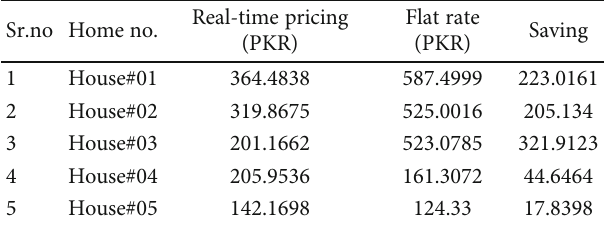
Table 10: Real-time pricing and fl at rate comparison. Sr.no Home